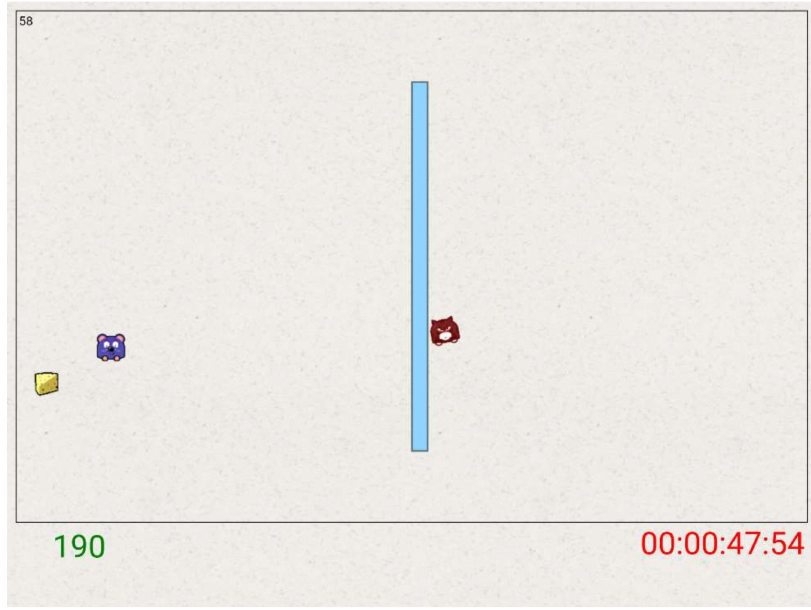
Figure 1. Game screen in Cat vs. Mouse: The blue mouse is controlled by titling the tablet. The idea is to collect cheese chunks whilst avoiding the